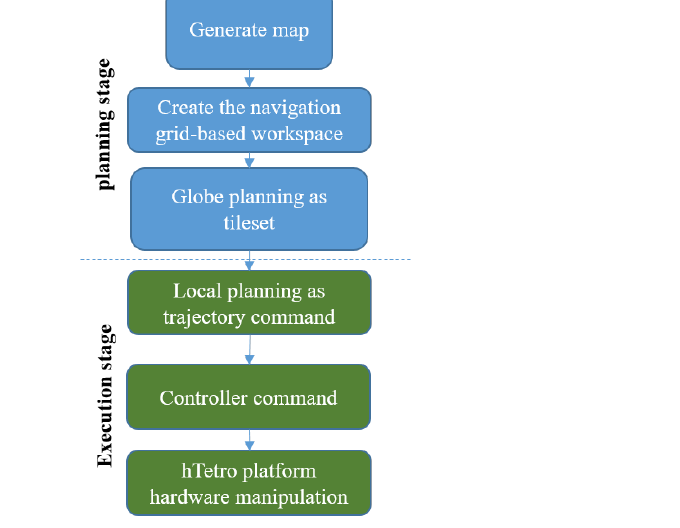
Figure 1. The proposed tiling-based motion planning framework for hTetro: hinged tetro